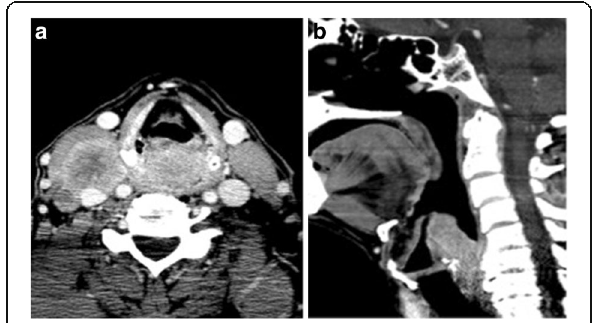
Fig. 2 A case of 82-year-old male patient with hypopharyngeal squamous cell carcinoma. This is associated with right-sided necrotic nodes at IIB and III. They show central necrosis at the largest node with a very thick irregular margin showing slight “ hyper-enhancement, ” and grouping non-conglomerated appearance. ( a ) Shows the main tumor and nodal disease at two levels, while ( b ) image shows the longitudinal tumor. The features of “ necrosis ” are consistent with squamous cell carcinoma metastatic node according to our